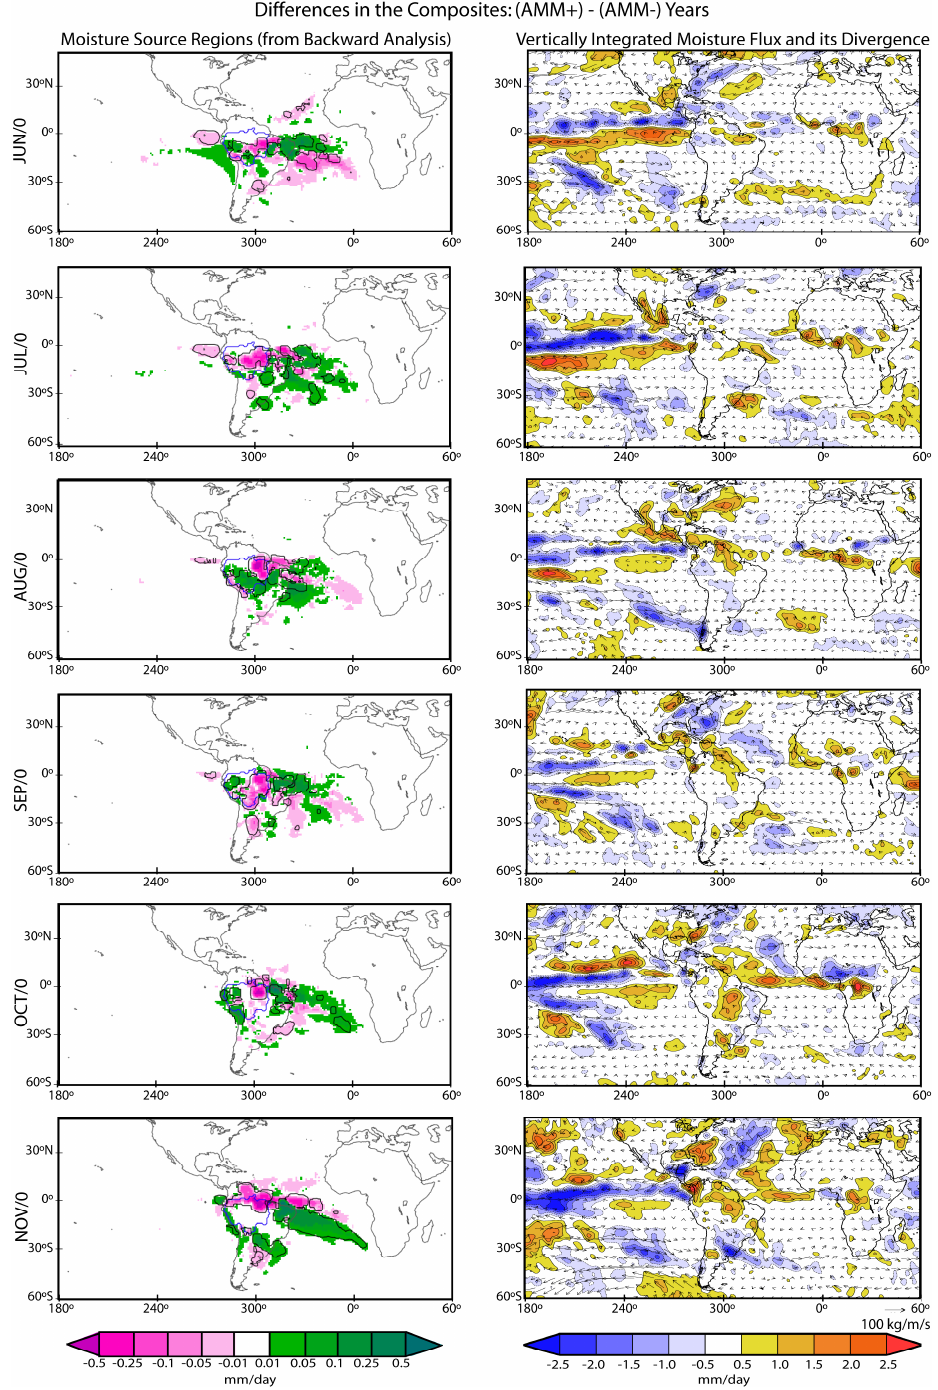
Figure 7. As Fig. 5, but for extreme AMM episodes. Pink (green) colours in the left-hand column indicate regions where the sources are more intense during AMM + (AMM − )